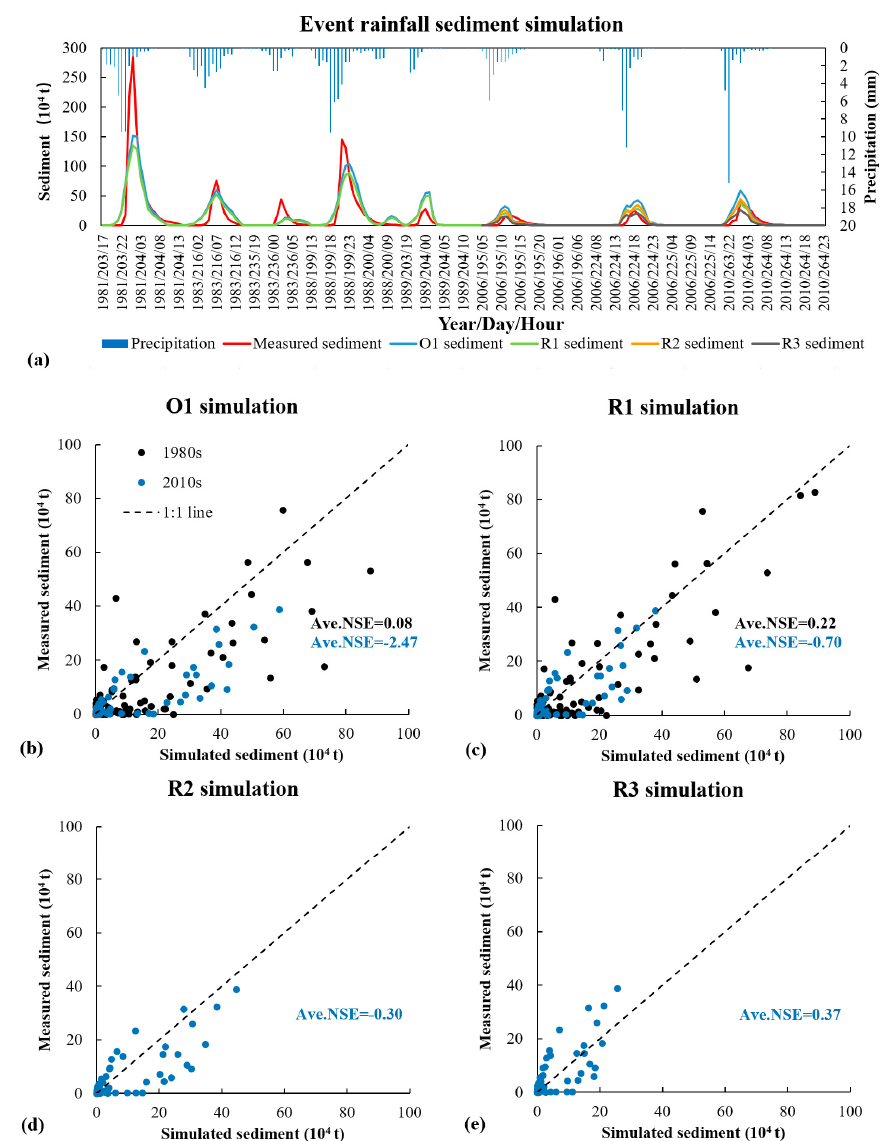
Figure 8. Comparison of observed and simulated sediment discharge for eight events in the Pianguanhe Basin. ( a ) Event rainfall sediment simulation; ( b ) Sediment in O1 simulation; ( c ) Sediment in R1 simulation; ( d ) Sediment in R2 simulation; ( e ) Sediment in R3 simulation.